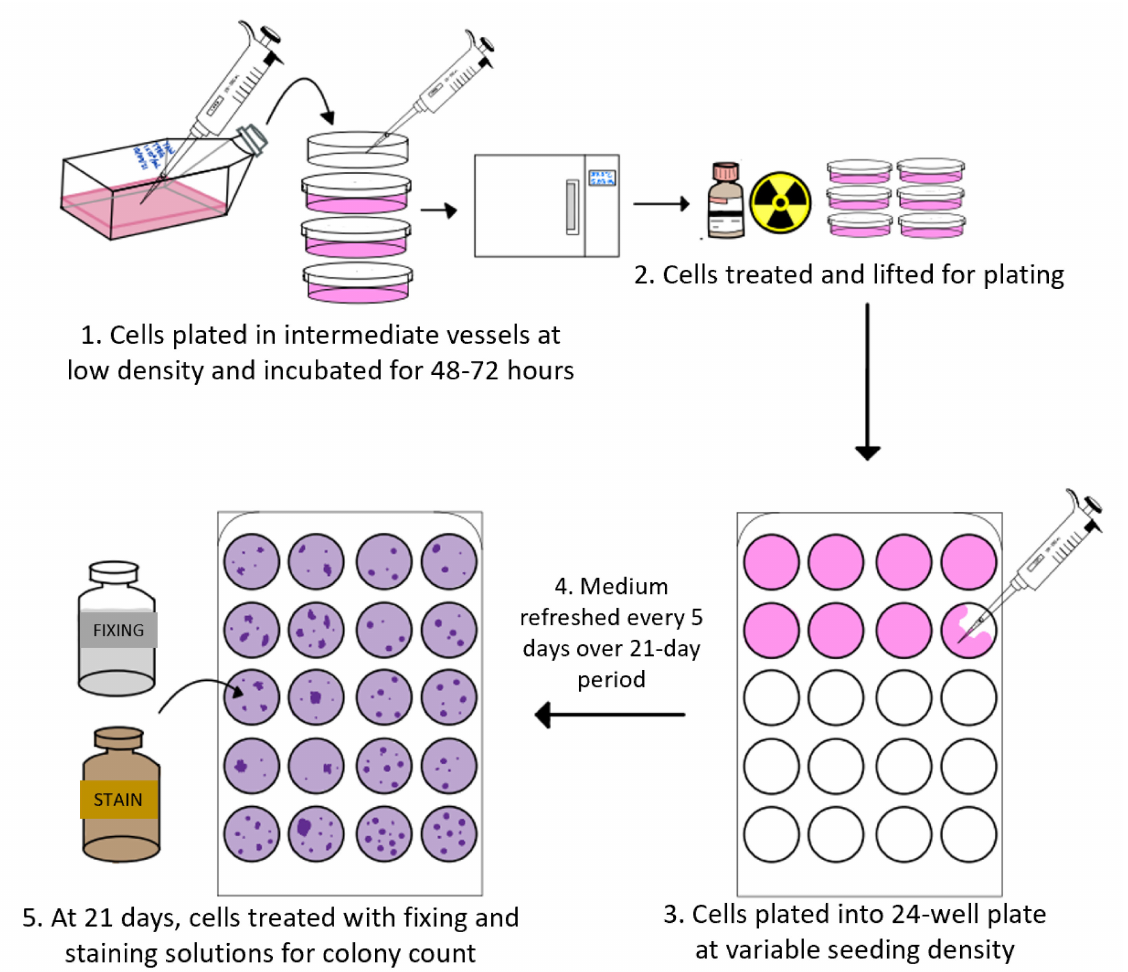
Figure A3. Preparation of clonogenic assays. Step 1: Cells were taken from culture vessels and seeded in intermediate vessels at reduced cell density to ensure count consistency with the variable seeding strategy. Following seeding, cells were incubated for 2–3 days prior to treatment to allow for recovery. Step 2: Cells were treated and lifted for plating. Step 3: Cells were plated into clonogenic assay well plates at the variable seeding density. The plate was placed into the incubator for the duration of the experiment. Step 4: Medium was refreshed every 5 days for the duration of the experiment to ensure ample access to nutrients. Step 5: At the endpoint, cells were treated with fixing and staining solutions for final manual colony